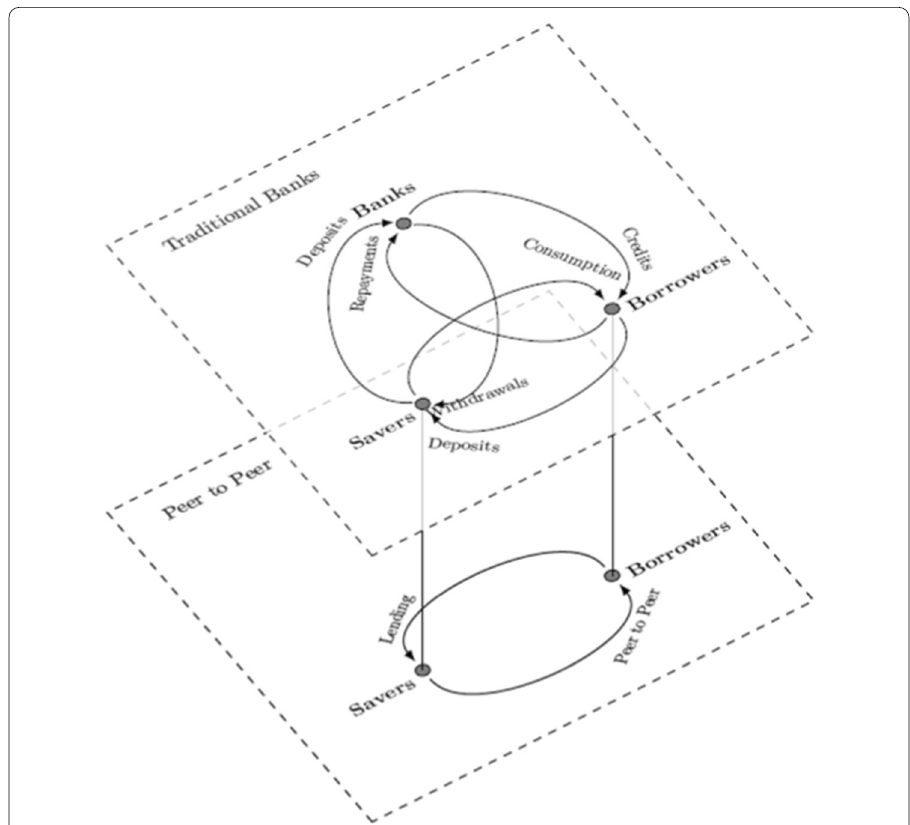
Fig. 3 The traditional view of banks ecosystem between savers and borrowers, atop the Internet which is matching savers and borrowers directly in a peer-to-peer way. The Klein (1971) theory of the banking firm does not incorporate the mirrored dynamics, and as such needs to be extended to reflect the digital innovation that impacts both borrowers and severs in a peer-to-peer